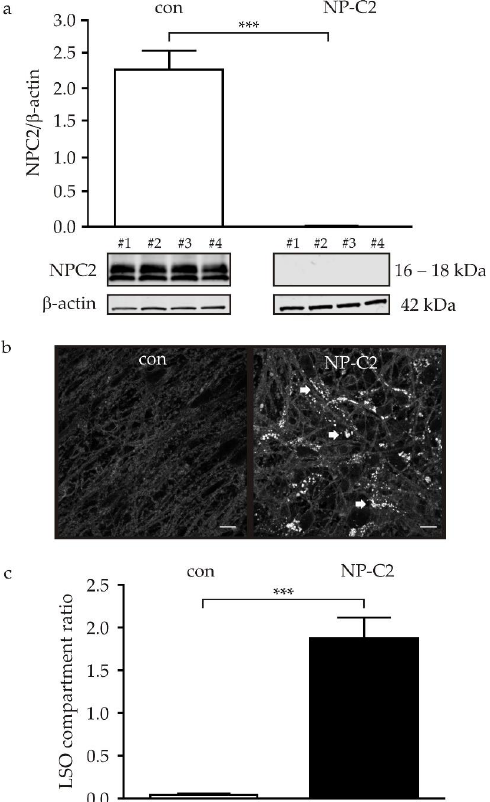
Figure 2. Detection of NPC2 protein and cholesterol accumulation. ( a ) Evaluation of NPC2 protein amount in control cells (white bar) and NPC2-deficient cells (black bar) by Western blot. NPC2 was detected in control cells as two distinct bands of 16 and 18 kDa. In contrast, no signal was observed in NPC2-deficient cells. An example of a complete Western blot membrane is shown in Figure S1. ( b ) Cholesterol accumulation was analyzed by means of filipin staining. In control cells (con), no obvious cholesterol accumulation was observed. In contrast, NPC2-deficient cells displayed a clearly visible accumulation (indicated by arrows). ( c ) Quantification of the lysosome-like storage organelles compartment ratio (LSO compartment ratio) revealed a significantly increased ratio in NPC2-deficient cells. *** = p < 0.001. con = control cell line; NPC2 = NPC2-deficient cell line. Scale bar in b = 10 µ